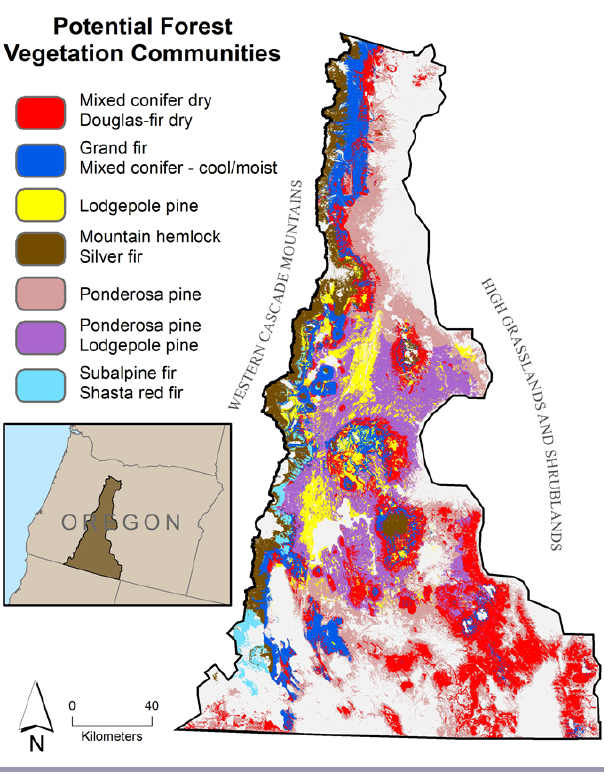
Fig. 1. Potential vegetation forest community types (late successional plant communities) in the central and south- central Oregon, USA, study region. Forest vegetation communities that are dependent on frequent (10–50 yr) low- to mixed-severity fire include: mixed conifer dry, Douglas-fir dry, portions of mixed conifer cool/moist, ponderosa pine, and ponderosa pine/lodgepole pine. Fire regimes in other forest vegetation communities have longer return intervals and have been less influenced by human activities. Map derived from the Integrated Landscape Assessment Project